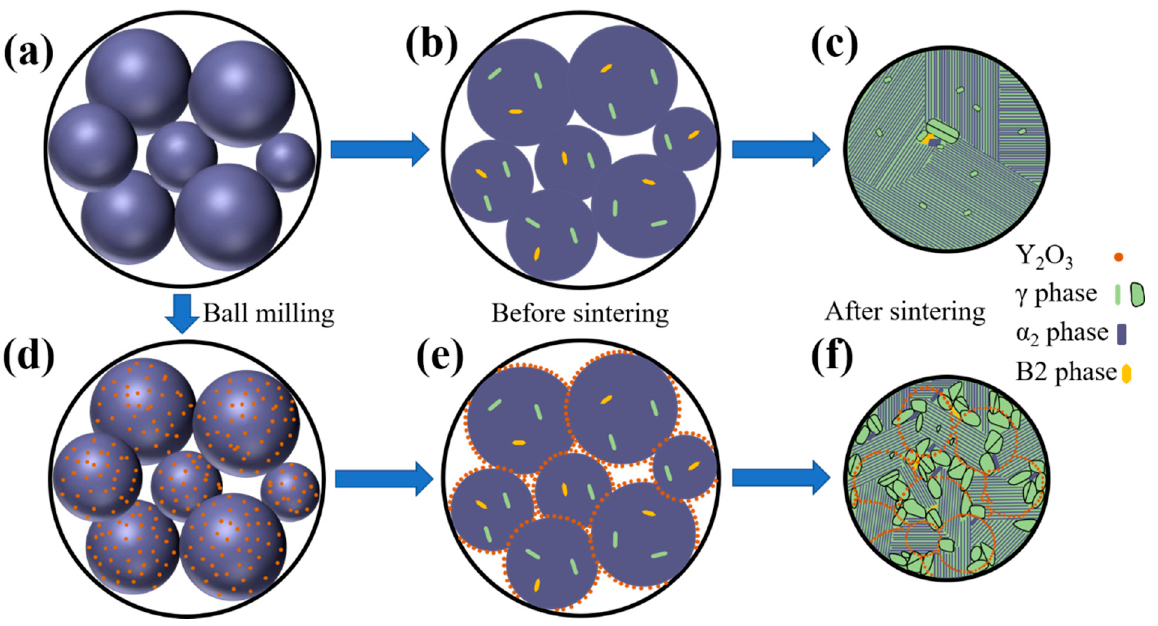
Figure 5. Schematic diagrams of the sintering process: ( a – c ) no addition nano-Y 2 O 3 ; ( d – f ) addition nano-Y 2 O 3 .